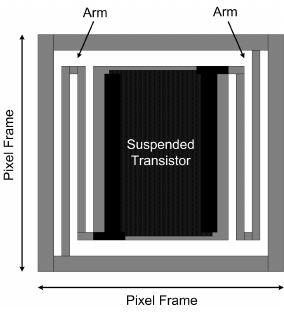
Figure 1. Schematic representation of the TMOS sensor pixel.